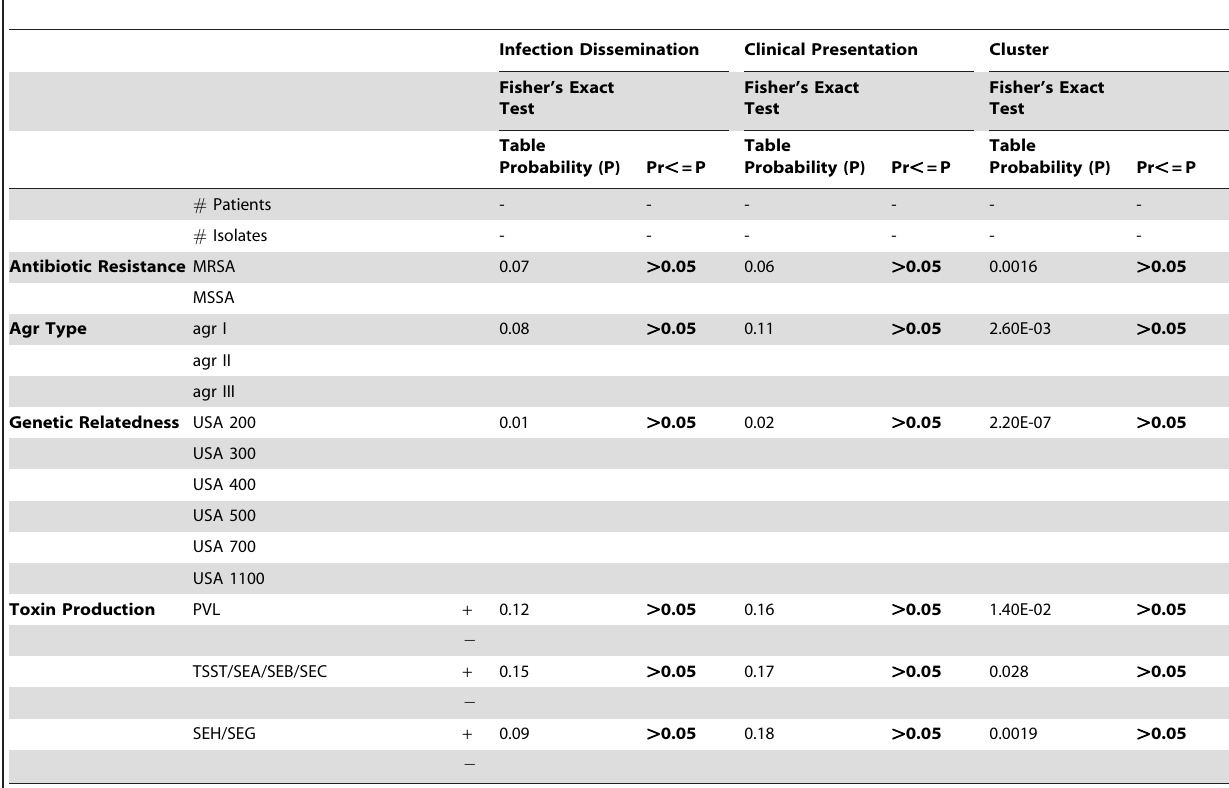
Table 3. Distribution of bacterial isolate characteristics by infection localization, presentation and